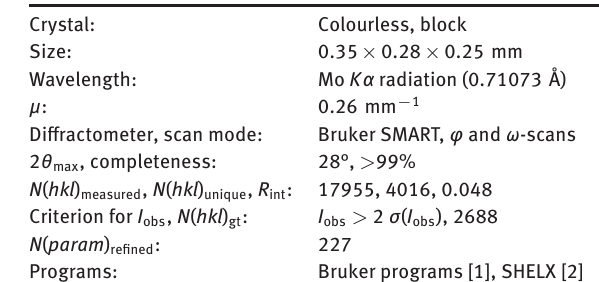
Table 1: Data collection and handling.